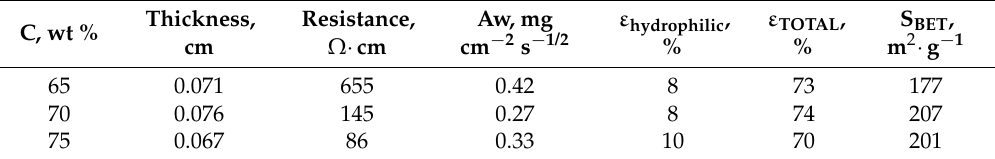
Table 3. Effect of wt % carbon on the properties of the cast active layer